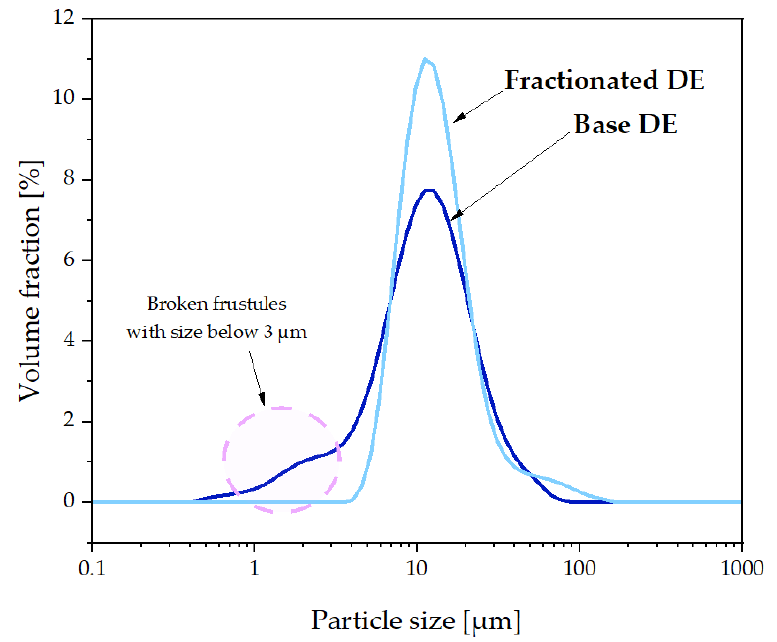
Figure 4. Particle size of the fillers, basic and fractionated diatomaceous earth.